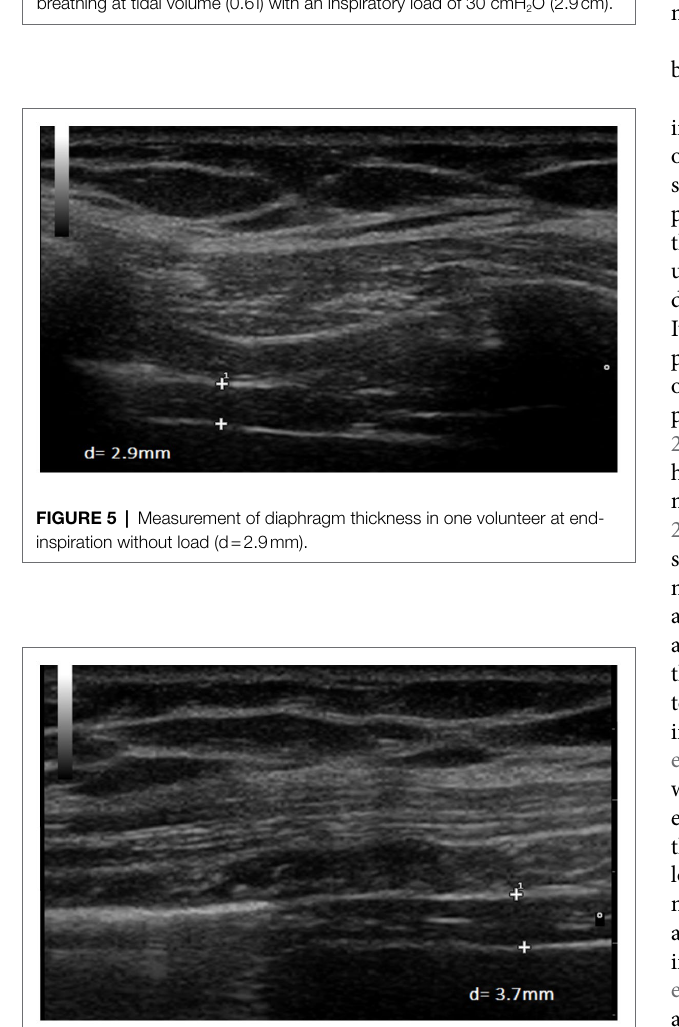
FIGURE 6 | Measurement of diaphragm thickness in the same volunteer at end-inspiration with an inspiratory load of 30 cmH 2 O ( d = 3.7 mm).